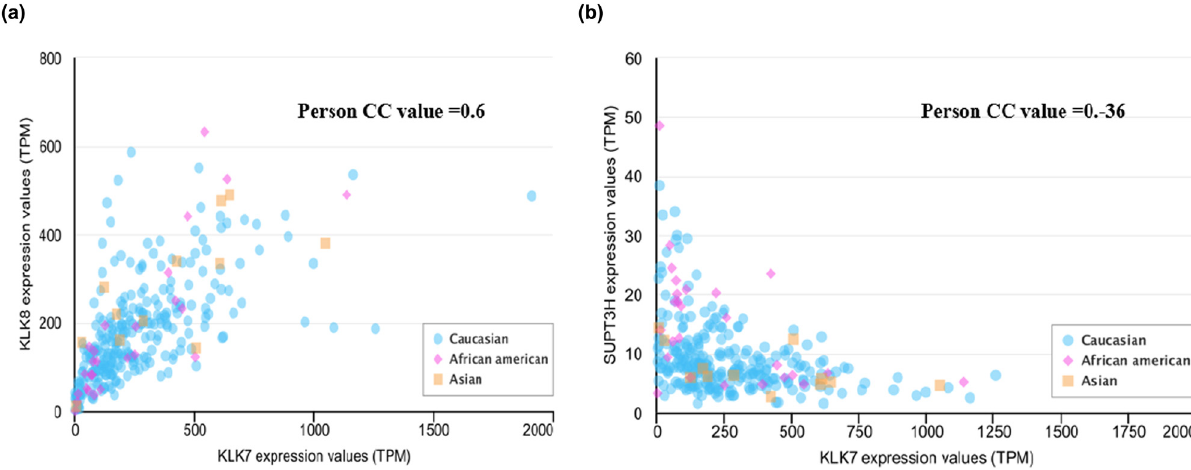
Figure 4: Correlation of KLK8 , SUPT3H and CHEK1 gene expression in ovarian cancer. ( a ) Gene expression correlation between KLK7 and KLK8 in OV, ( b ) gene expression correlation between KLK7 and SUPT3H in OV.